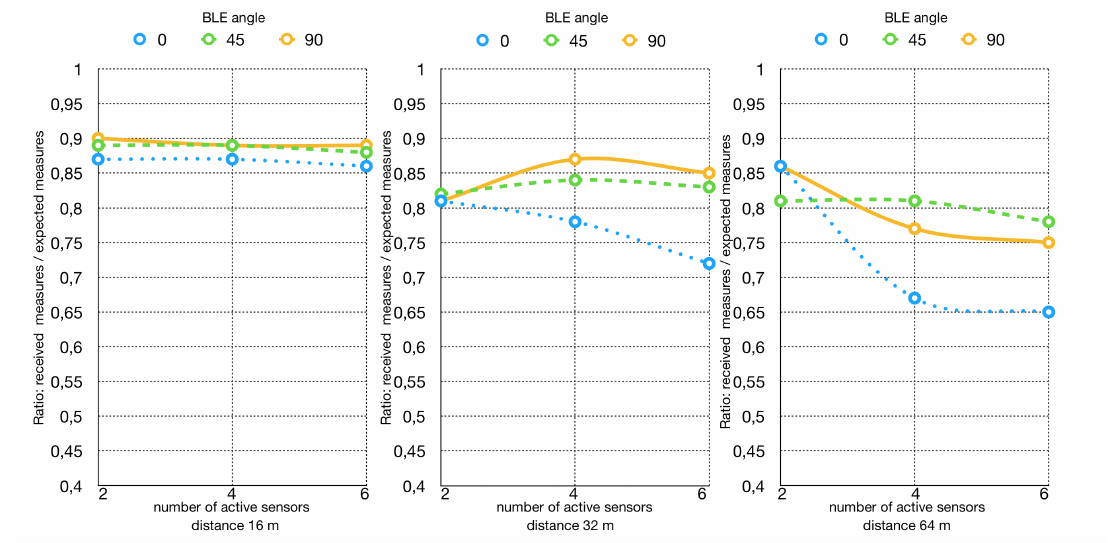
Figure 4. Bluetooth® reception rate taking into account tag orientation.